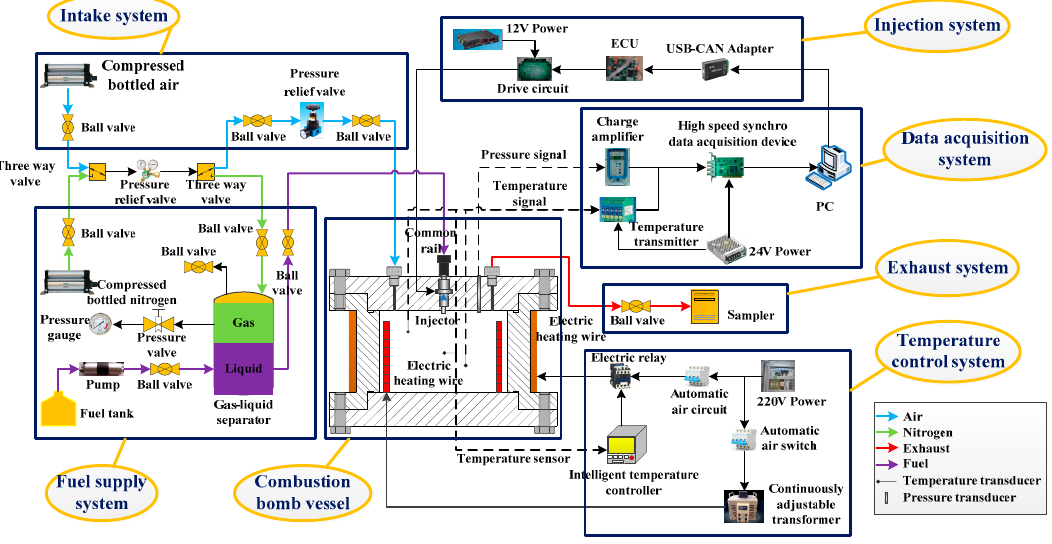
Figure 1. Constant volume bomb system. Table 1. The main equipment of the experiment.